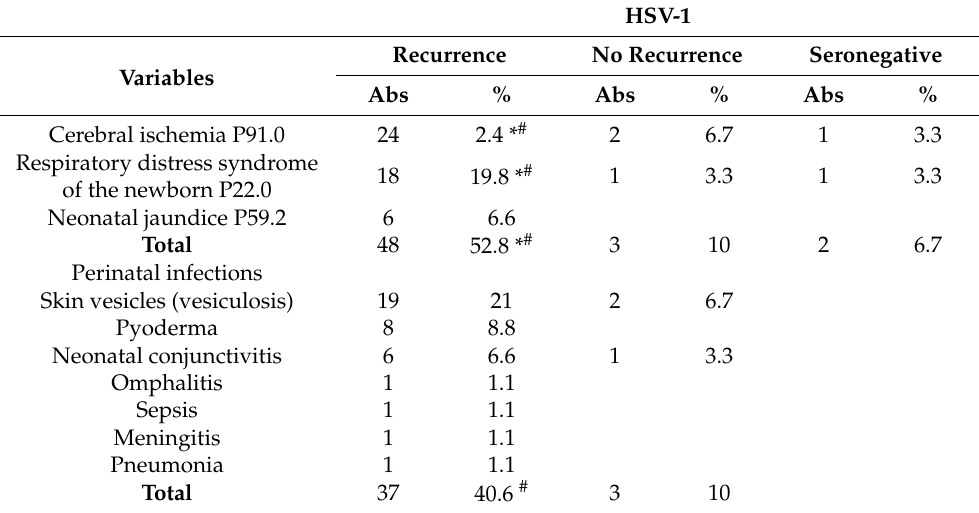
Table 10. The frequency and structure of diseases of newborns of the study groups.